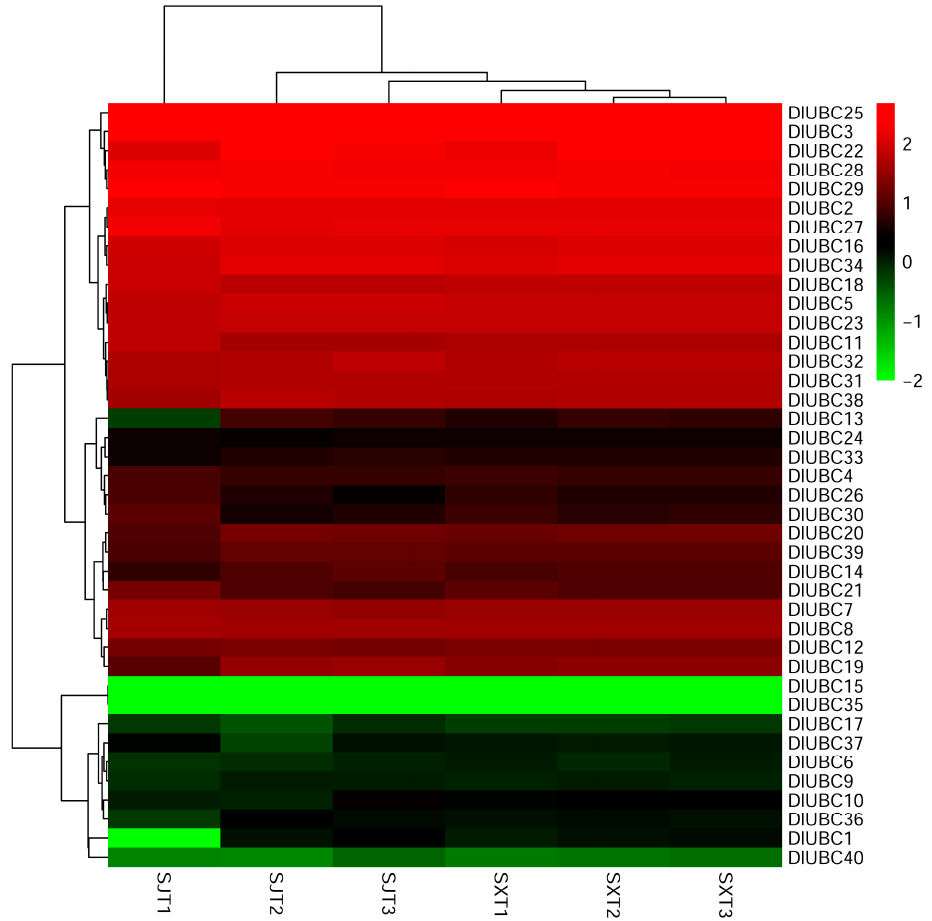
Figure 4. Heat map of the comparative expression level of UBC genes during the three flowering stages of the ‘SJ’ and “SX”. Genes with comparatively low expression values are shown using shades of green, and high expression values are represented using shades of red. The three flowering stages of SJ are indicated by SJT1, SJT2 and SJT3. The three flowering stages of SX are indicated by SXT1, SXT2 and SXT3.